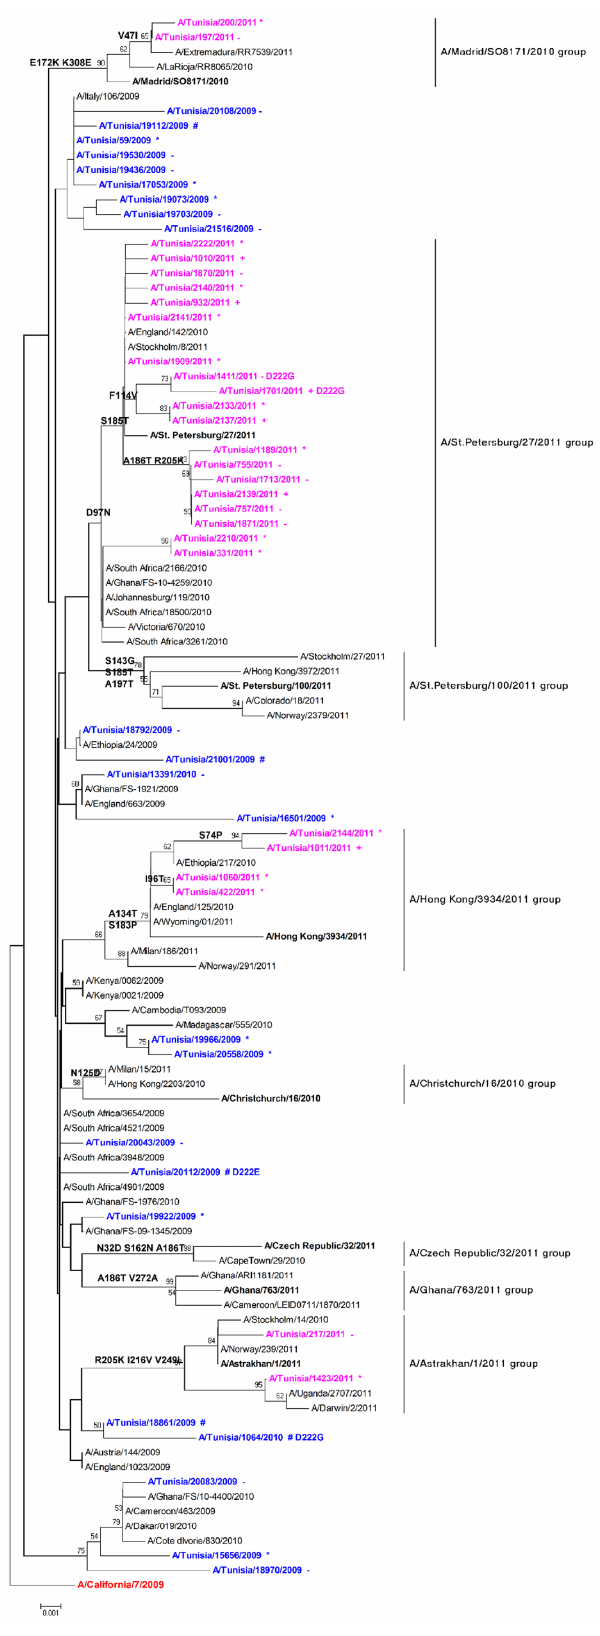
Figure 5. Phylogenetic relationship of partial length HA sequences of influenza A(H1N1)pdm09 viruses from fatal, severe and mild cases in Tunisia during 2009–2010/2010– 2011 seasons. Fatal case # ; case in care unit + ; severe case *; mild case- . The tree was rooted with the vaccine strain A/California/07/2009 (boxed) as outgroup. Branch lengths are drawn to scale. Signature amino acid changes (H1 numbering) are annotated at the nodes of each cluster. Viruses with 222G or 222E changes are marked in the